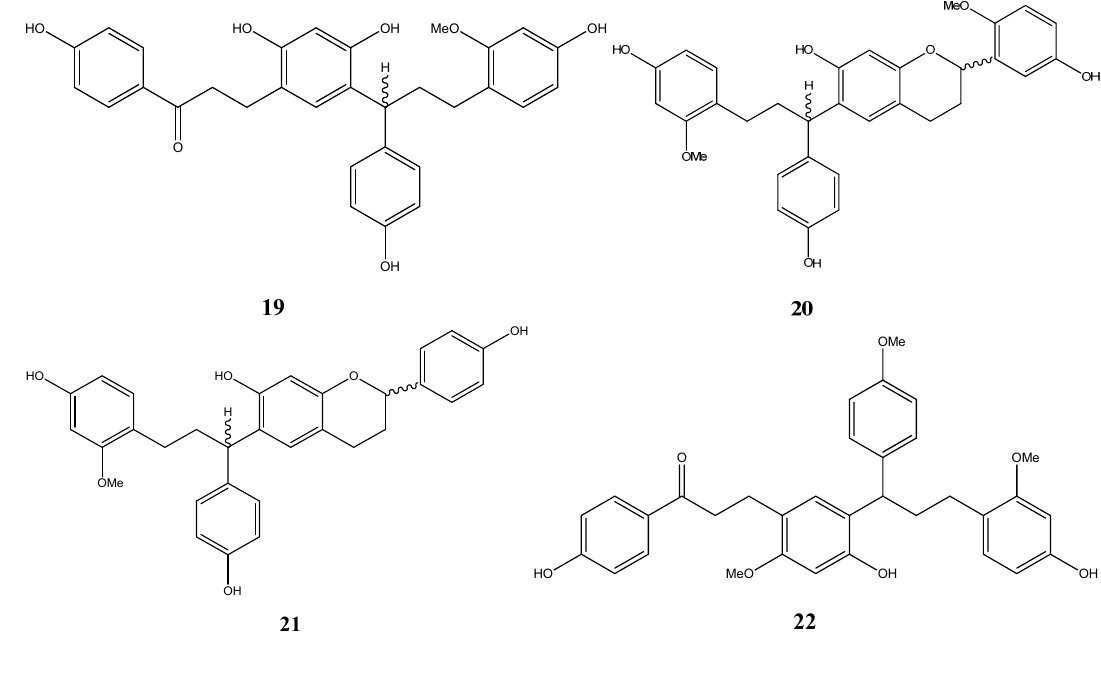
Figure 4. Structures of polymeric flavonoids.